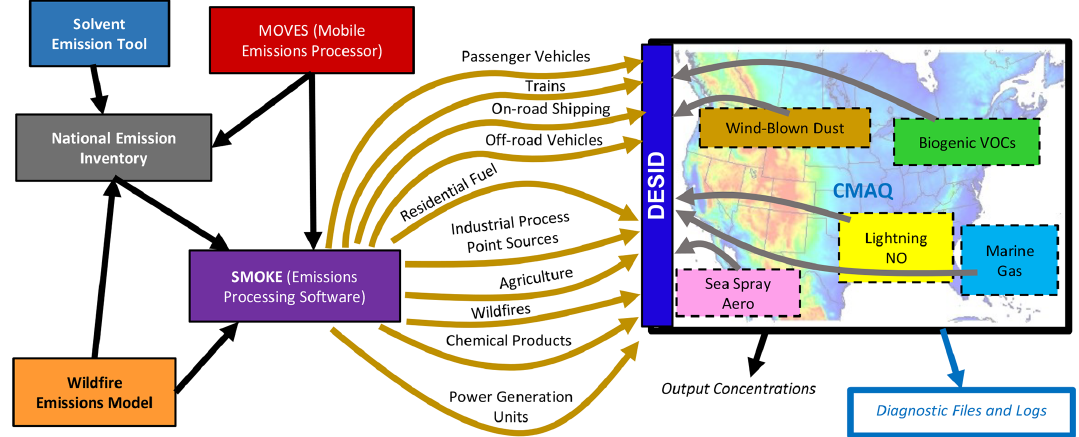
Figure 1. Example of potential emissions streams and data sources used that inform CMAQ. The offline streams and emission models depicted are not an exhaustive list of all data sources that contribute to a standard CMAQ simulation for the US.